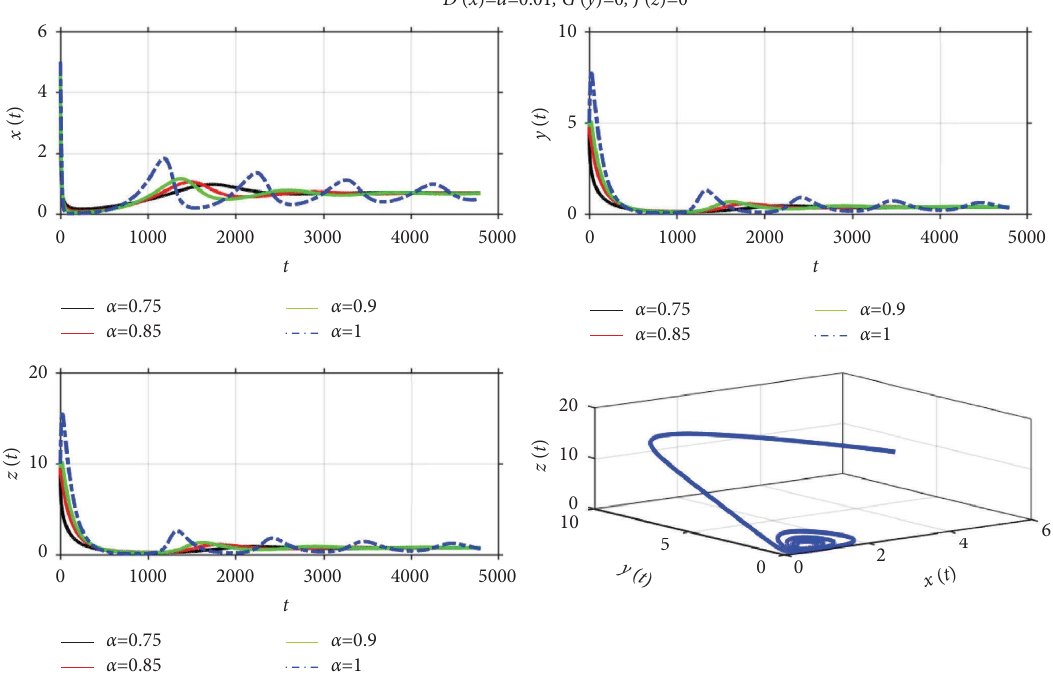
Figure 4: Population dynamics of the one prey-two predators system with D ( x ) � d � 0 . 01 , G ( y ) � 0 , J ( z ) � 0 , a � b � c � 0 . 1 , e � h � 0 . 3 , f � i � 0 . 2, α � 0 . 75 , 0 . 85 , 0 . 9 , 1 , and 3D-plot of x ( t ) , y ( t ) , and z ( t ) for α � 1 .